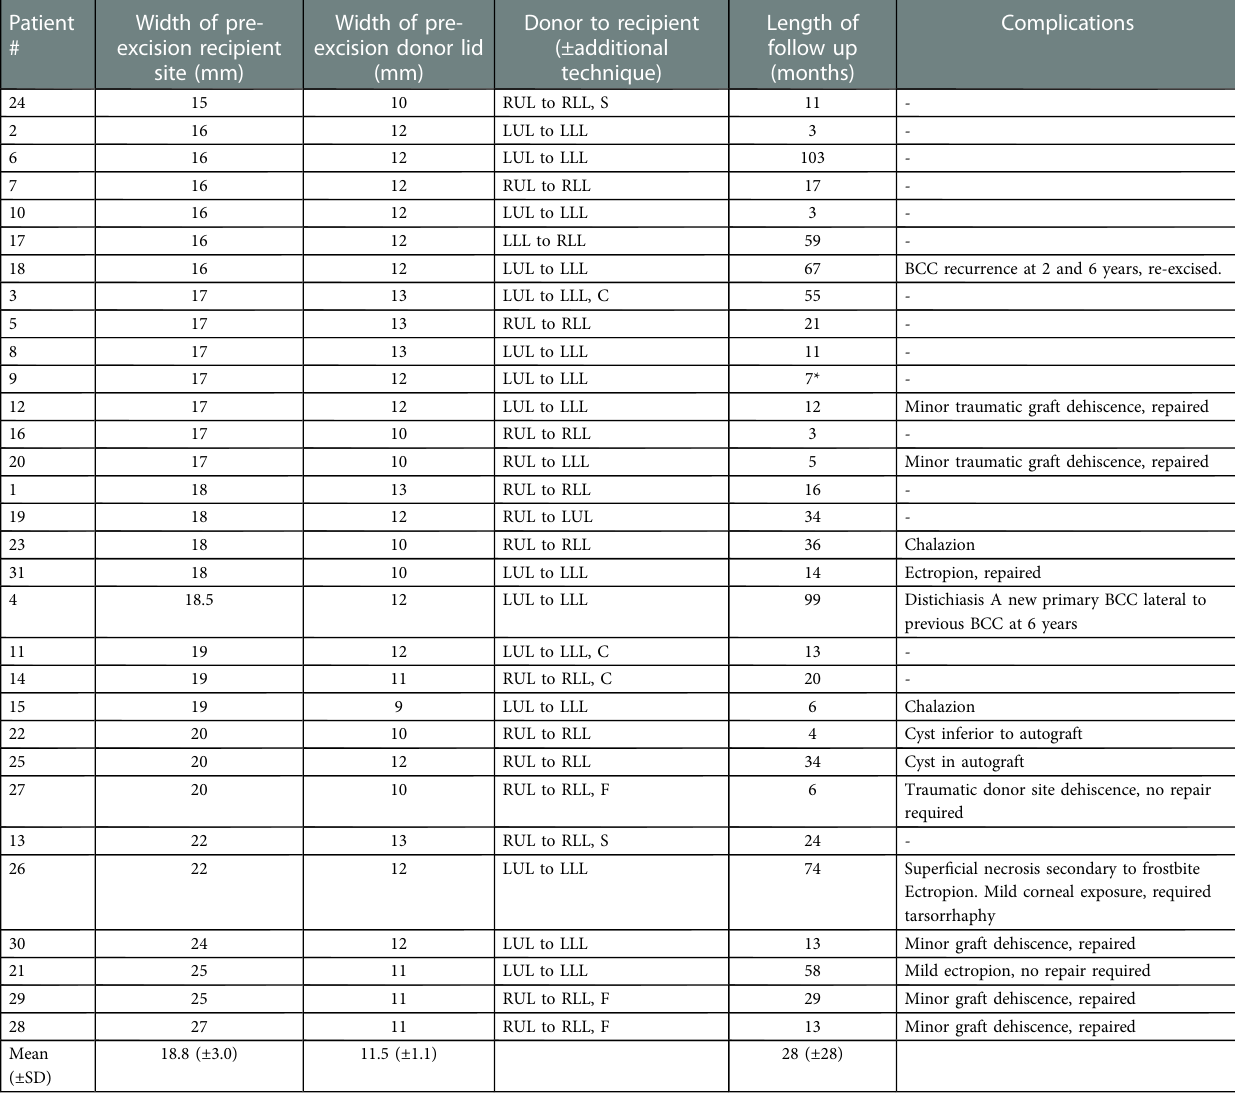
TABLE 1 Free bilamellar autograft measurements, locations, and complications, listed according to increasing size of recipient site. Patient